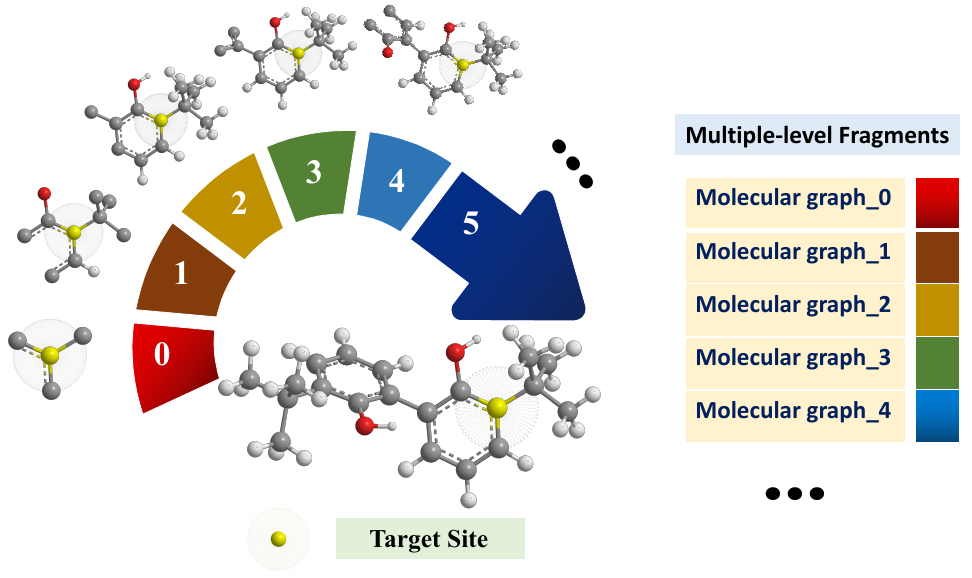
Figure 1. The generation of multiple-level molecular fragments within the framework of the F-GCN.